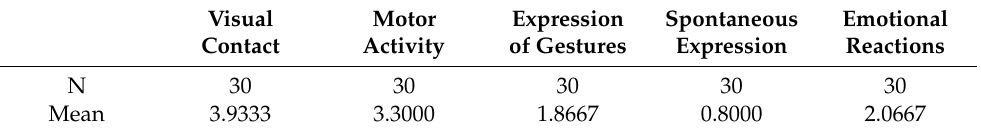
Table A5. Interest in the robot.